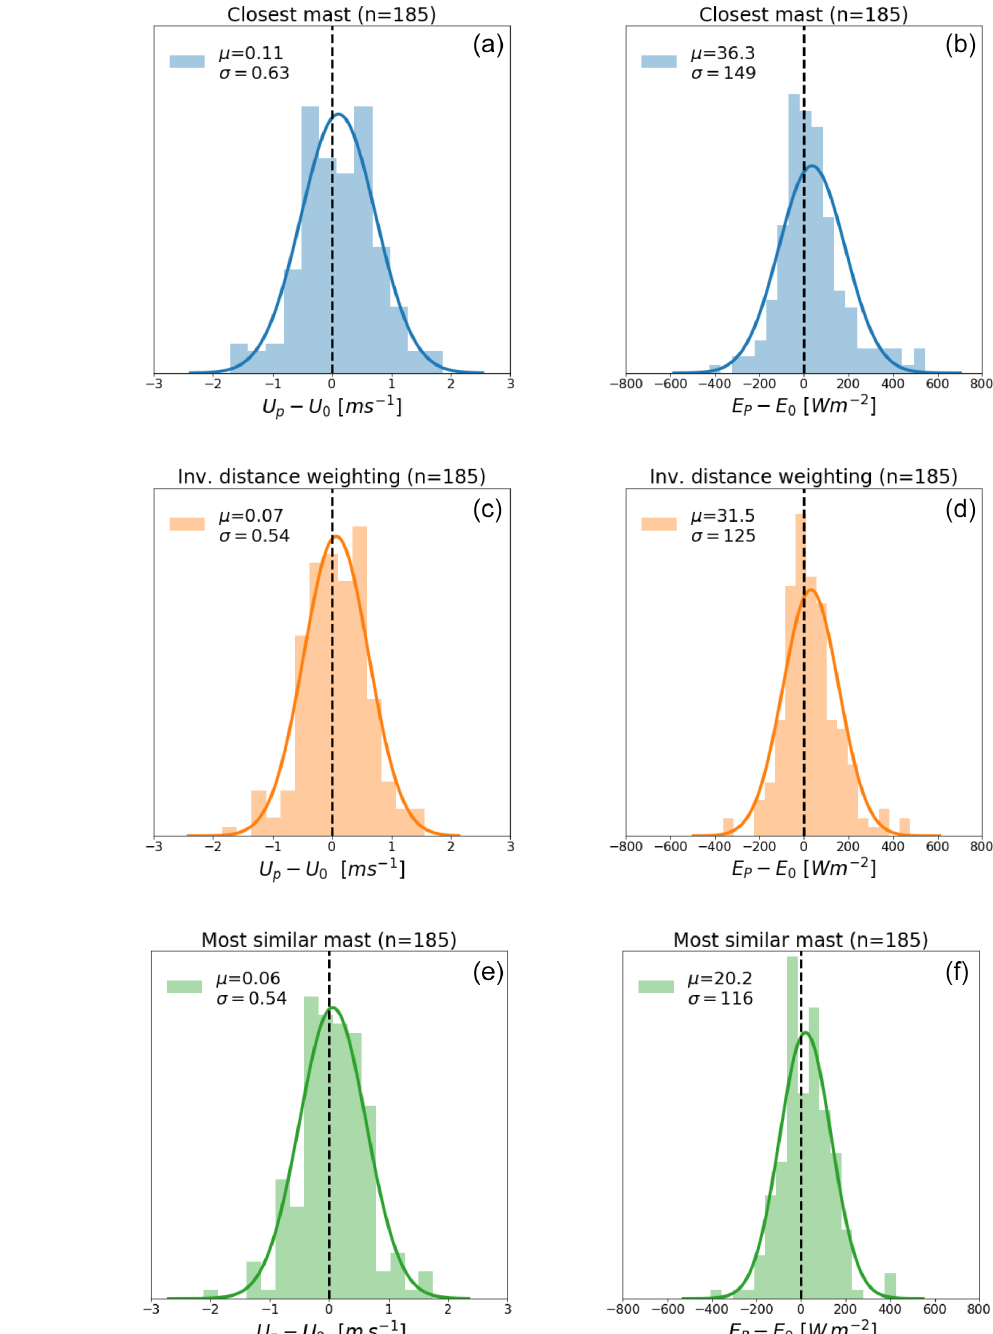
Figure 4. Histograms of the absolute wind speed (a, c, e) and power density (b, d, f) error when using the closest mast (a, b) , inverse-distance weighting (c, d) and most similar (e, f) strategies. The mean bias and standard deviations are given in the legend. All 185 mast positions have been predicted to make this